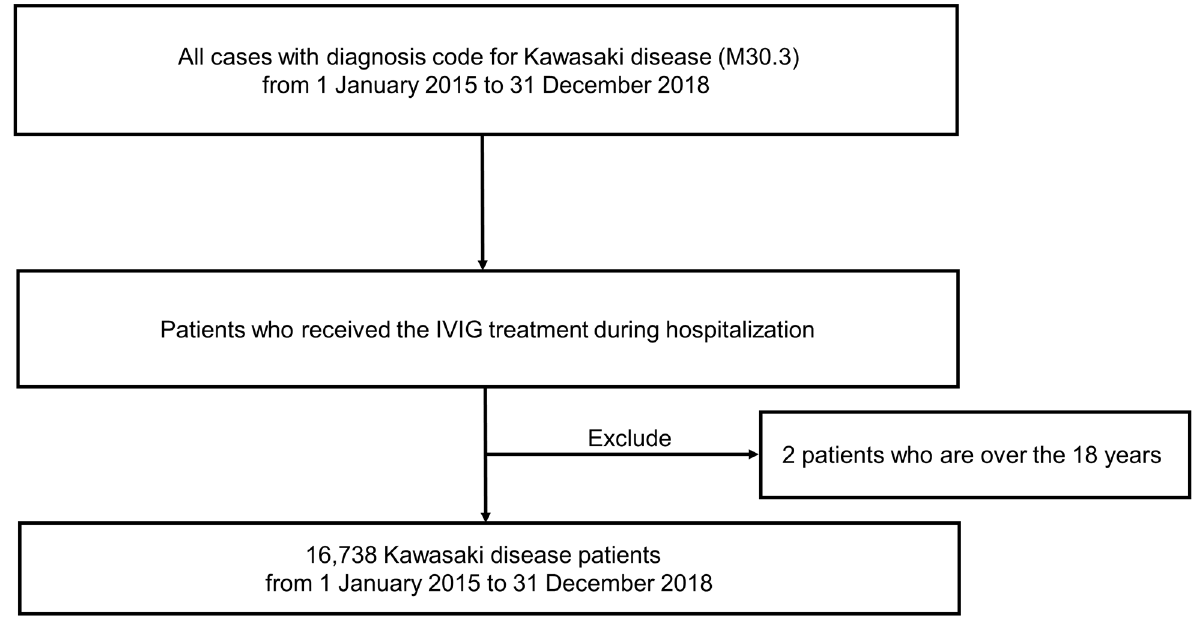
Figure 1. Flowchart illustrating patient selection.